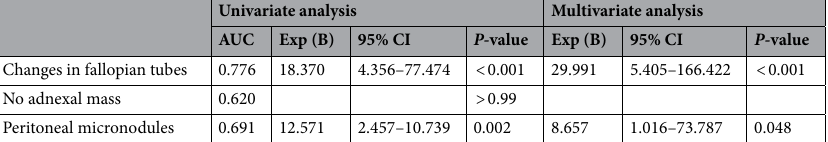
Table 3. Univariate and multivariate logistic regression analysis for differentiation of TB peritonitis from peritoneal carcinomatosis. AUC the area under the receiver operating characteristics curve, CI confidence interval.